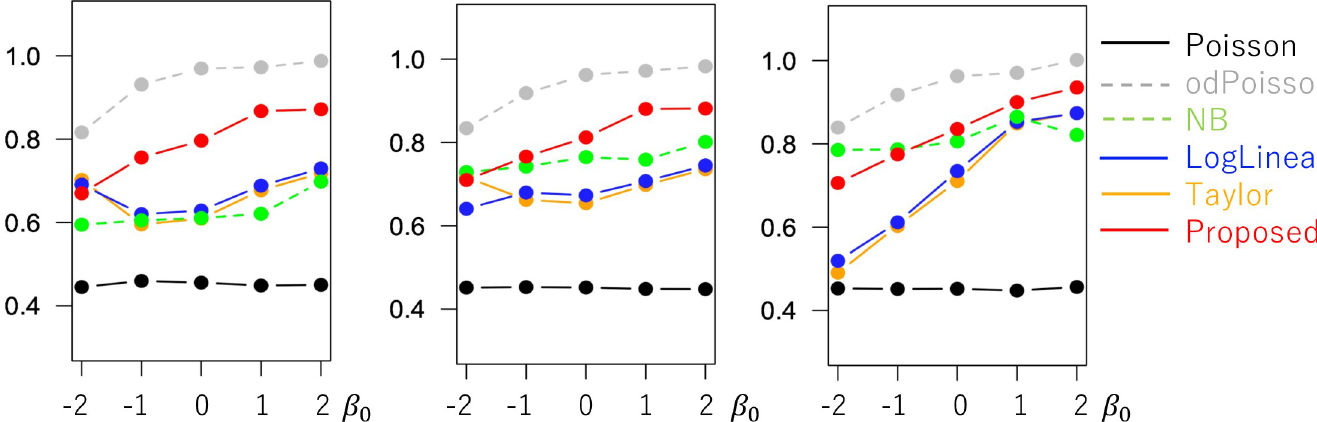
Fig 6. Means of (estimated standard error)/(standard deviation of the estimated coefficient values) when ( N = 200; x − axis: β 0 , y-axis: mean standard error).